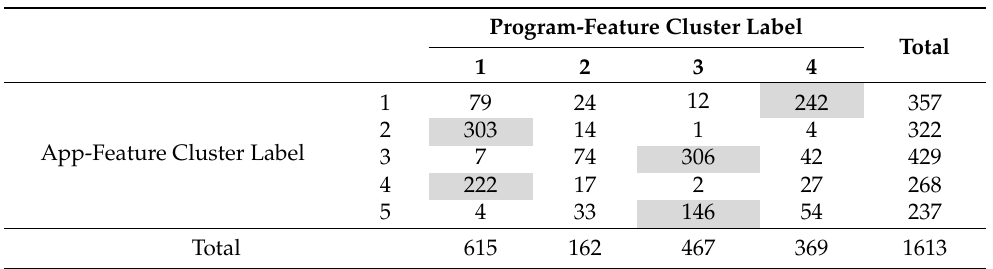
Table 1. Contingency table showing counts per each label pair resulting from the five app-feature and four program-feature clusters. Engagement personas identified by cross-referencing cells containing a high proportion ( ≥ 60%) of marginal total members (each persona shown in dark